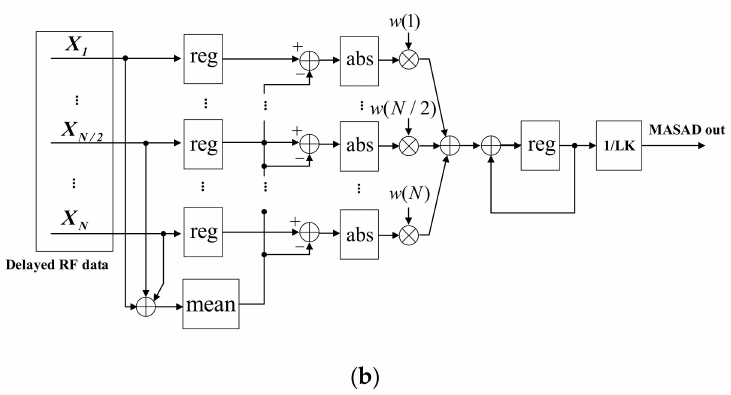
Figure 1. ( a ) Block diagram of the conventional dynamic receive beamformer (DRB) with the proposed MASAD and ( b ) the detailed block diagram of